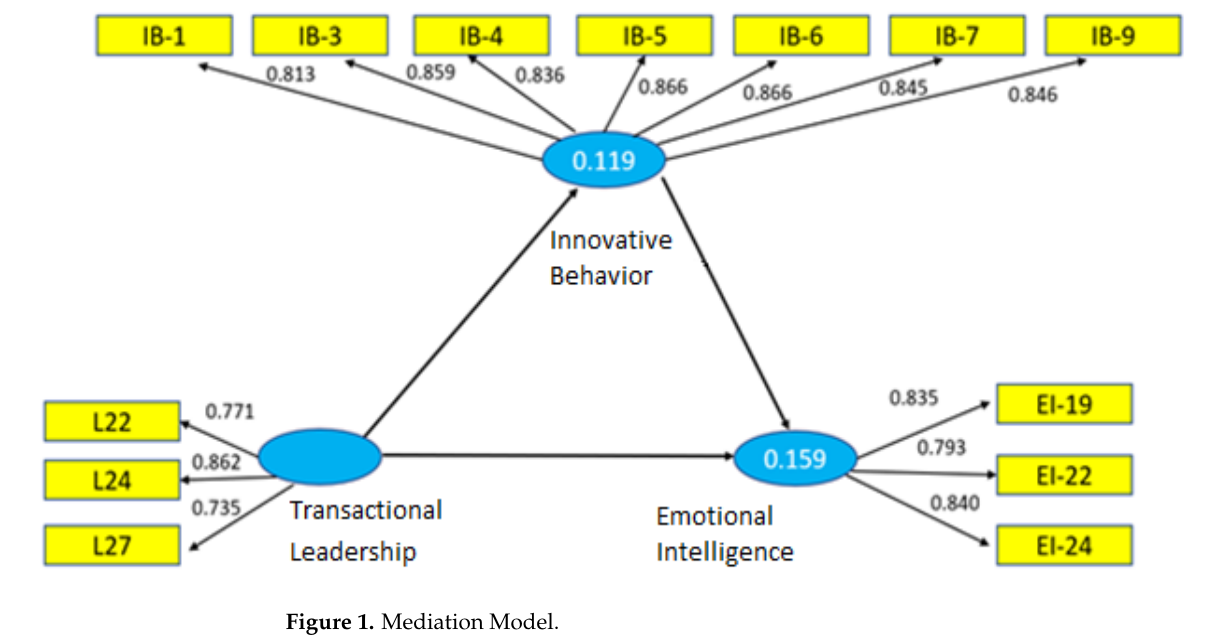
Figure 1. Mediation Model.